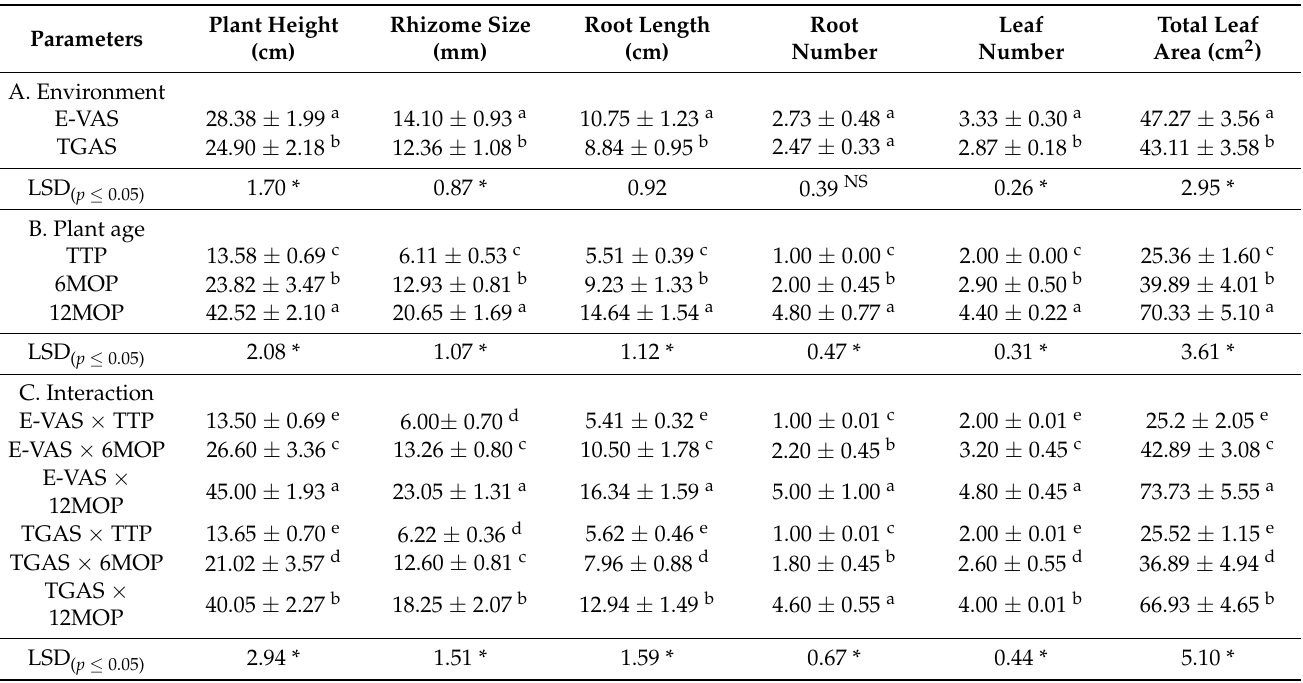
Table 2. Morphological response of different-aged tissue culture-derived date palm (cv. Khalas) plants under ex vitro acclimatization system (E-VAS) and traditional glasshouse acclimatization system (TGAS) environment for